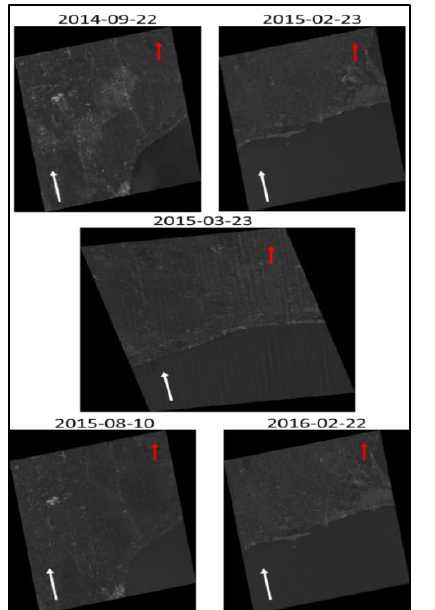
Figure 1. ALOS-2/PALSAR-2 scenes under study. The white and red arrows denote the directions of flight and geographic north